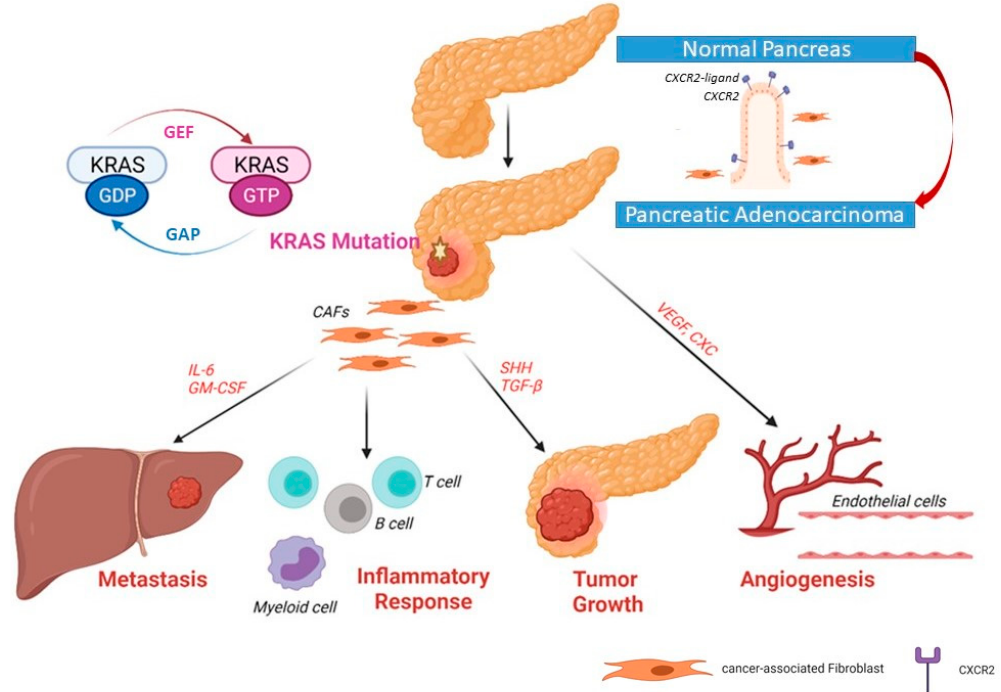
Figure 2. Upregulated expression of CXCR2 and its ligand in pancreatic ductal adenocarcinoma. In primary pancreatic tumors, the upregulation of CXCR2 expression induces the secretory function in cancer-associated fibroblasts (CAFs) Recruitment of fibroblasts to become CAFs can help tumor cells to grow, induce angiogenesis and invade the portal vein and metastasize to the liver.